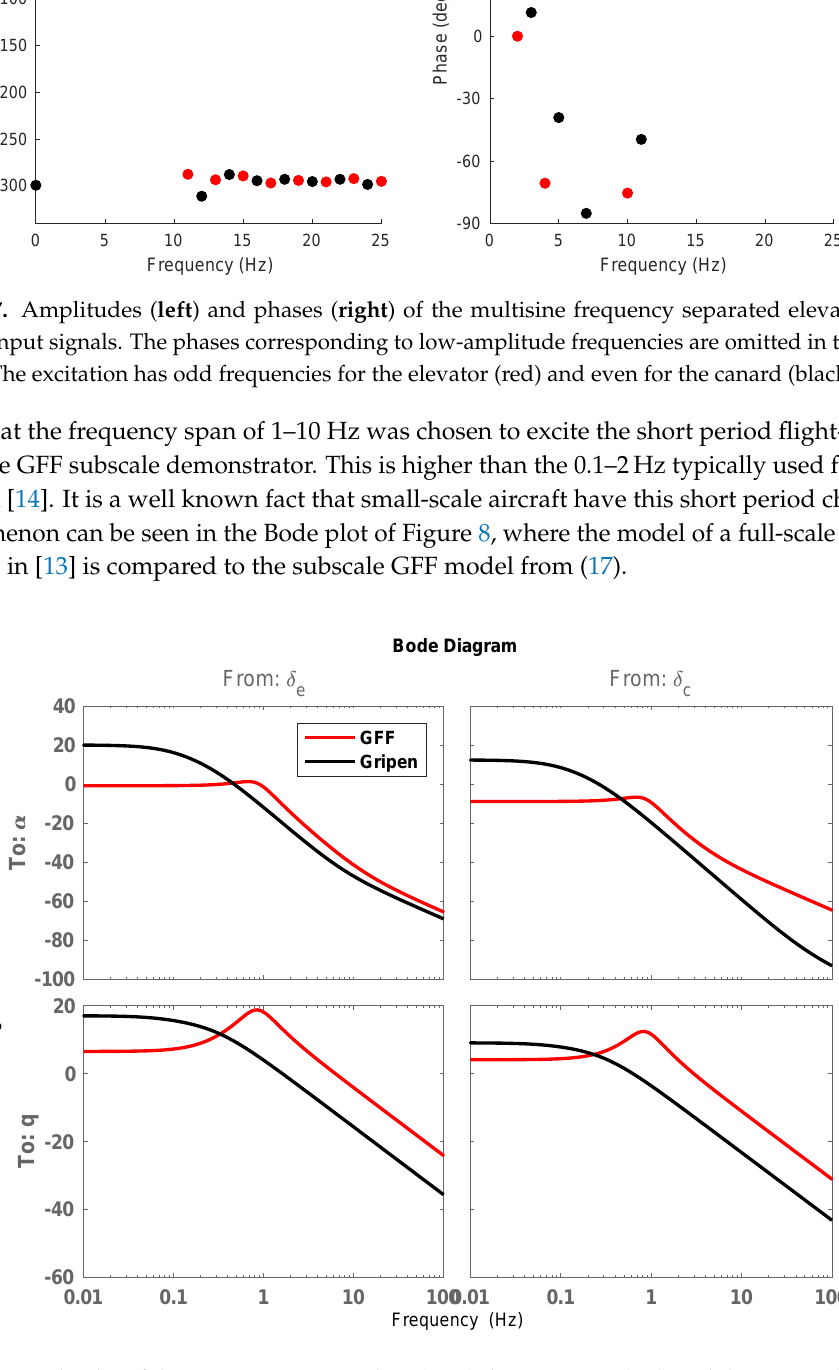
Figure 8. Bode plot of the Generic Future Fighter (GFF) demonstrator (red) and the Gripen